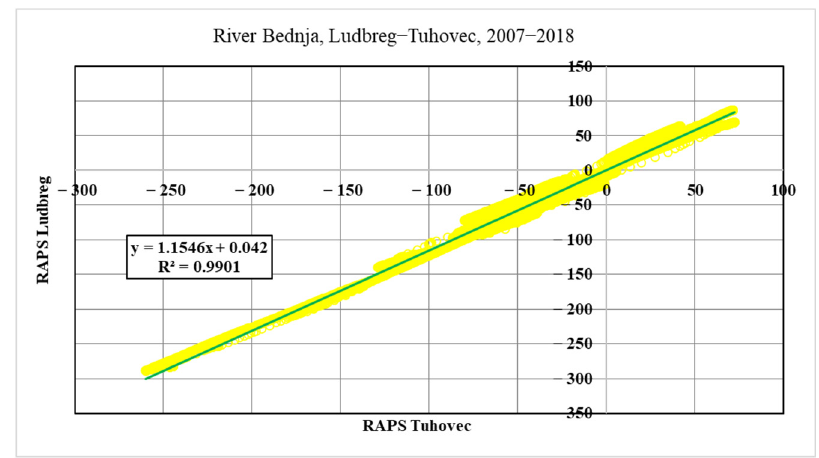
Figure 17. Correlation of RAPS values on Ludbreg and Tuhovec measurement stations.